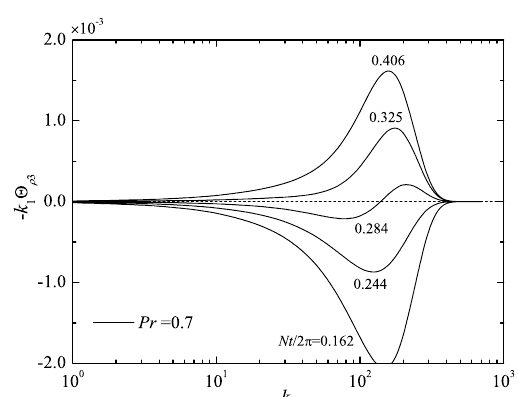
Fig. 5 Time variations of the cospectra of the vertical turbulent scalar flux in thermally stratified air flow. k 0 k = 200 m − 1 and k 0 p = 300 m − 1 . The value of PE 0 / KE 0 is the same as that in